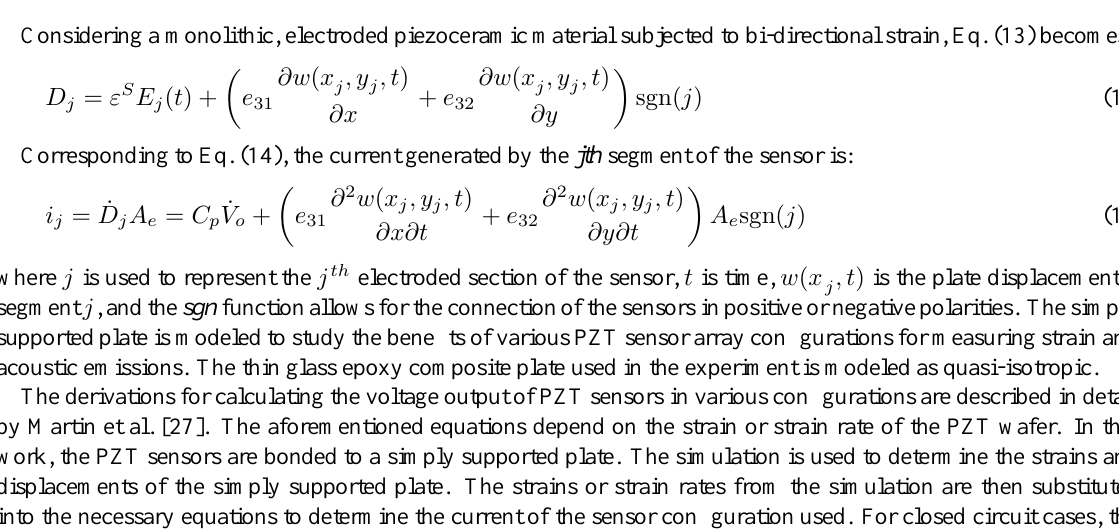
Fig. 5. Wave propagation at 10, 60, 110, 160, 210, 260, 310, 360 micro-sec due to center actuation by a PZT patch with an impulse moment